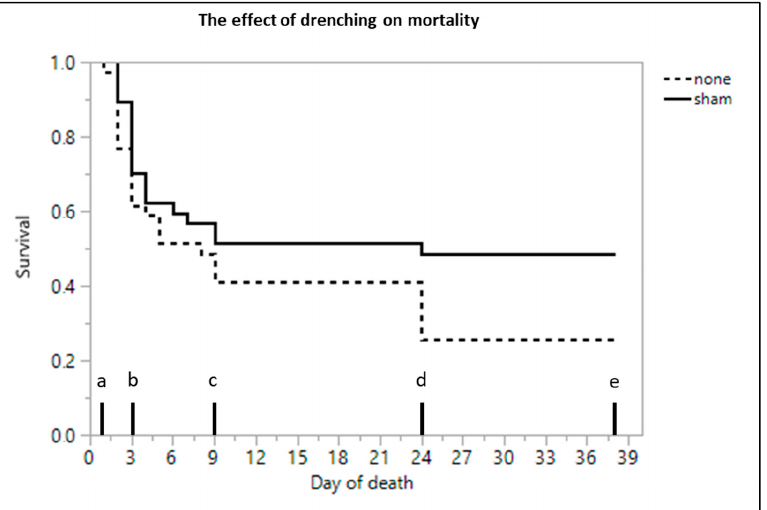
Figure 2. Cumulative mortality of low birth weight piglets that were sham drenched ( n = 37) or received no treatment ( n = 39) over time. Significant differences (Cox’s proportional hazard model, Kaplan–Meier survival plot, p ≤ 0.05) between time points are indicated by a different letter.